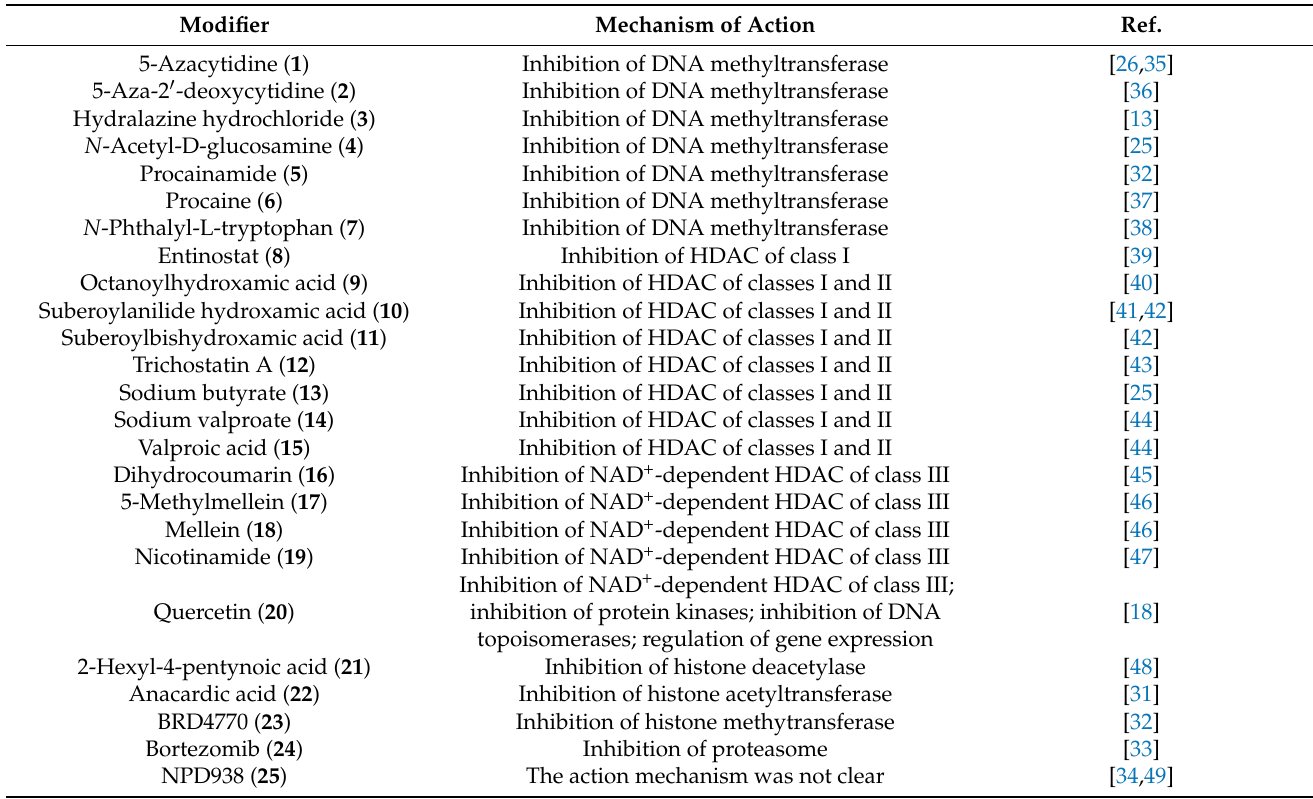
Table 1. Commonly used chemical epigenetic modifiers for generating specialized metabolism in